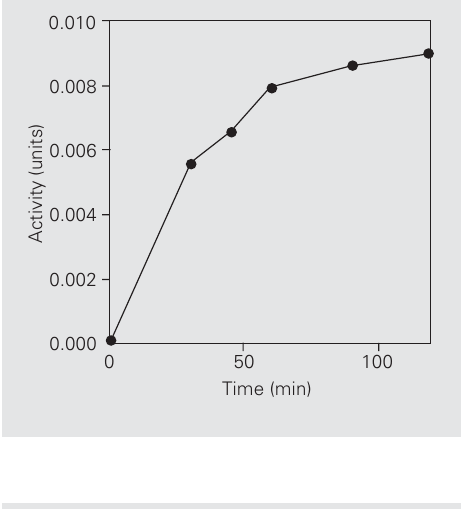
Figure 4. (cid:0) Effect of pH on the ac- tivity of epimastigote (cid:1) -L-fucosi- dase. (cid:0) The enzymatic assay was carried out as described in Mate- rial and Methods using 0.4 mg protein of an epimastigote ex- tract.